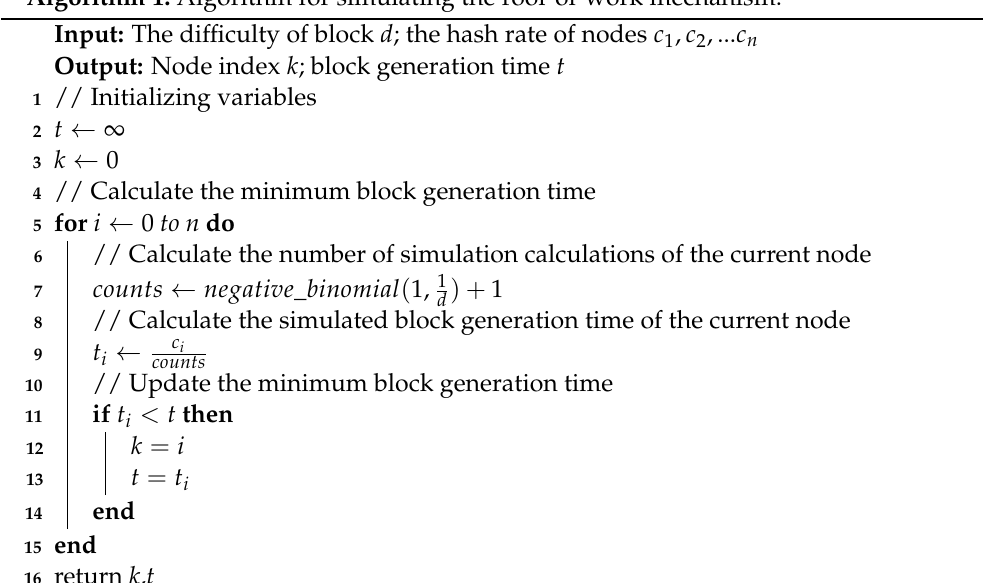
Algorithm 1: Algorithm for simulating the roof-of-work mechanism.